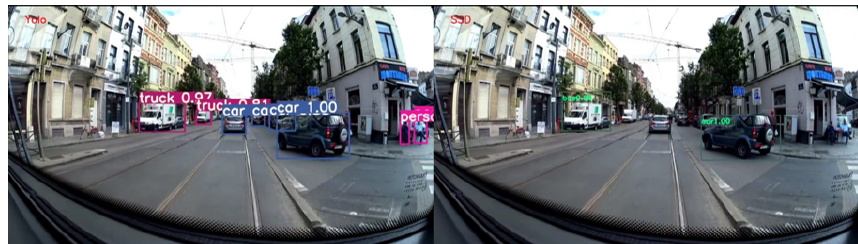
Figure 4. Performance comparison between YOLOv3 ( left ) and SSD ( right ) detectors.